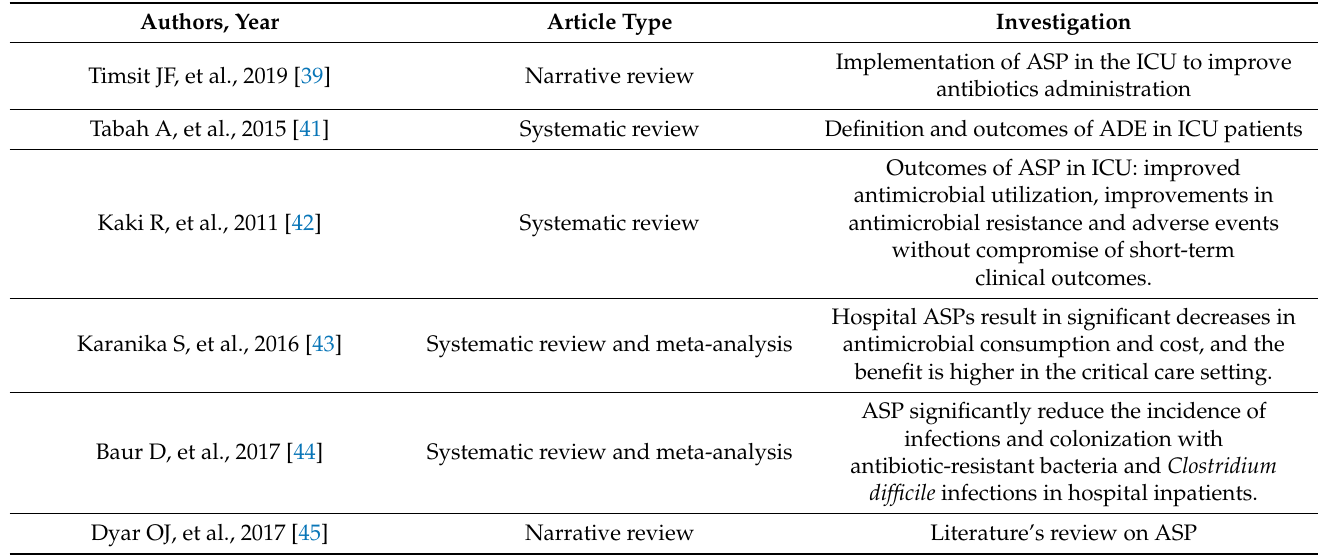
Table 2. Major studies available investigating the outcomes of Antibiotic Stewardship Programs